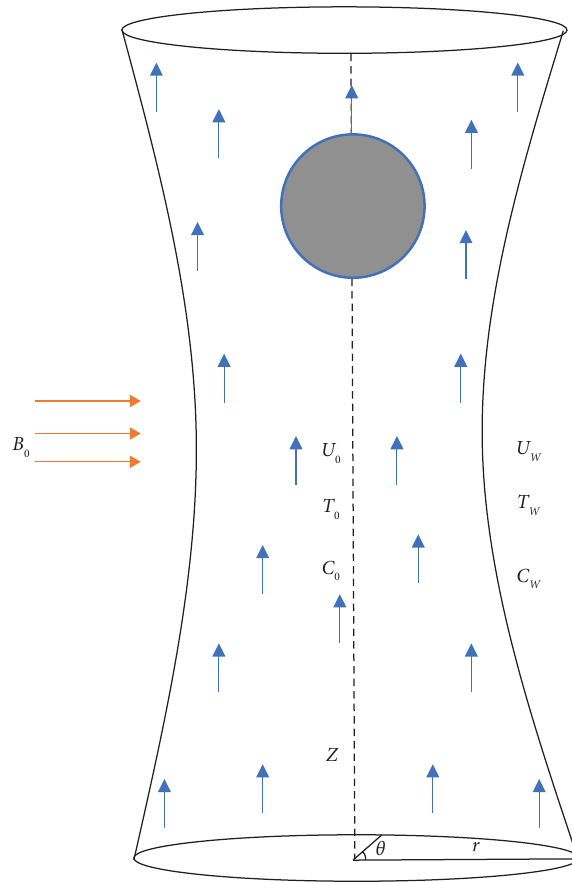
Figure 1: Geometry of the collapsible